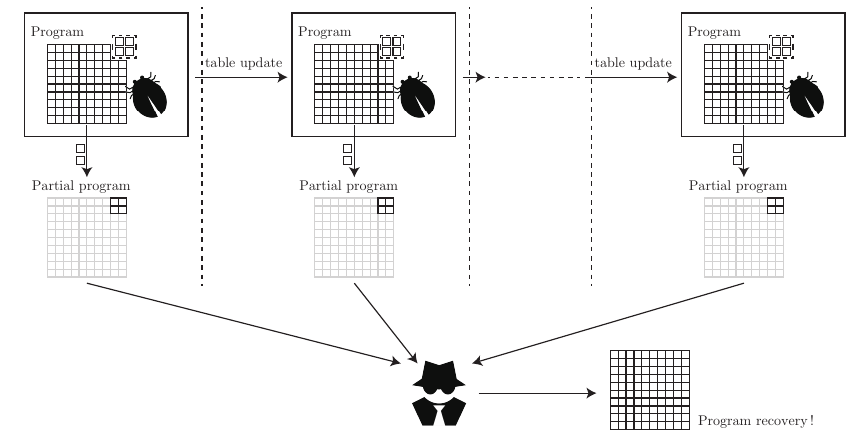
Figure 7: Attacks against